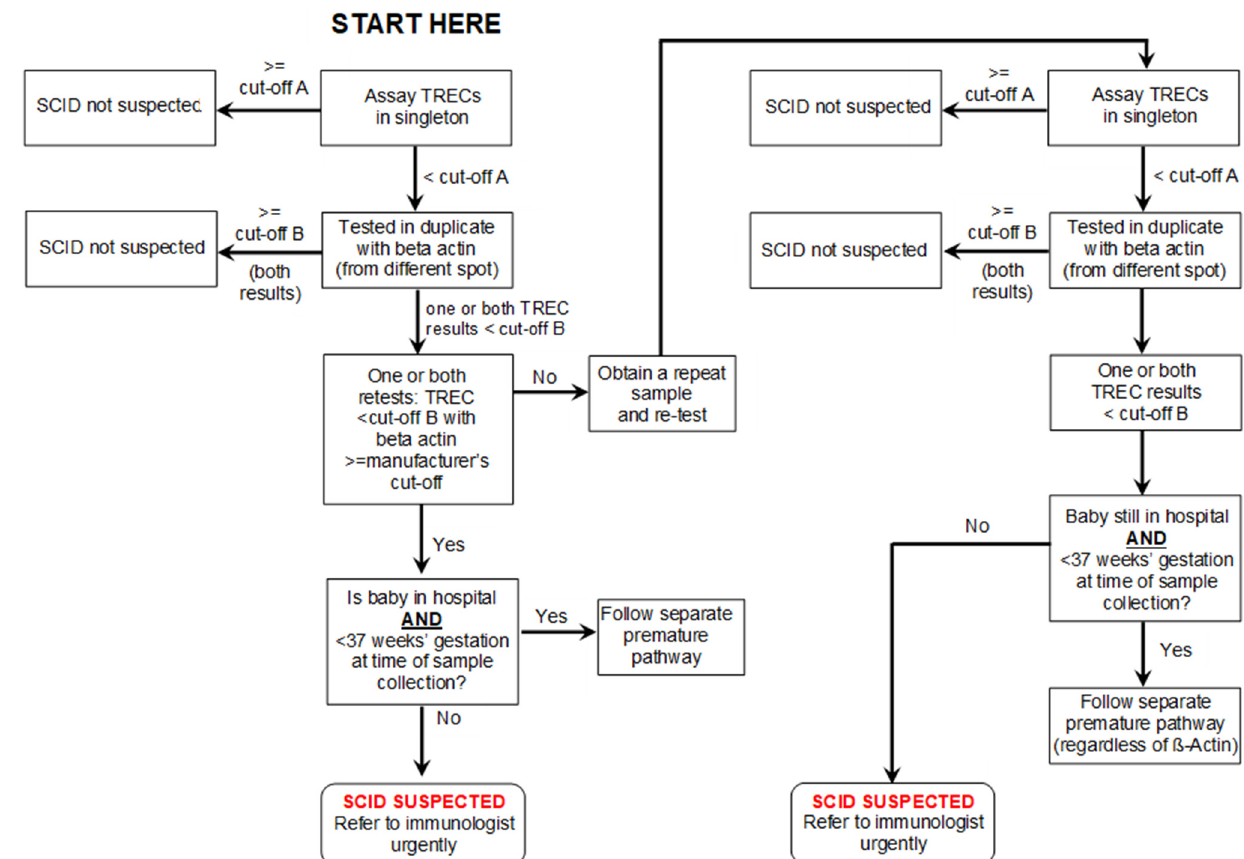
Figure 1. SCID screening algorithm (see table 1 for cut-off values).